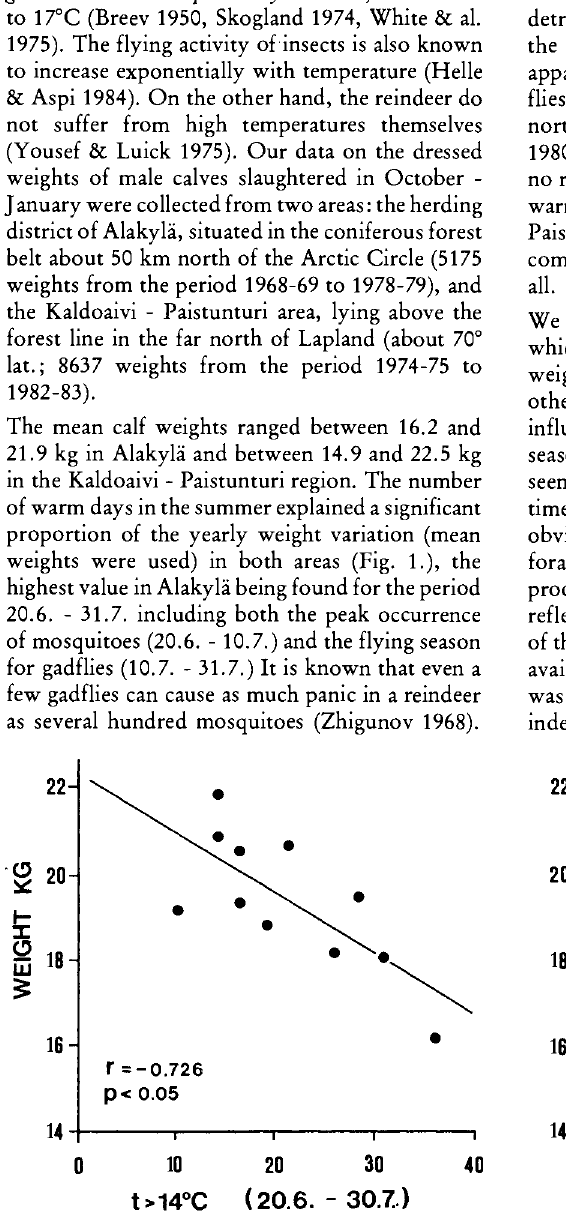
Forholdet mellom antall varme dager under insektsesongen og de gjennomsnittlige slaktevek ter for reinkalver om høsten eller tidlig vinter i Alakyla (venstre) og Kaldoaivi-Paistunturi (høyre). Hvert punkt er gjennomsnittsverdien av 85 - 1712